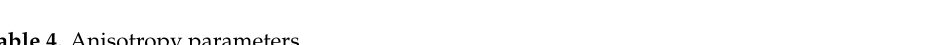
Table 4. Anisotropy